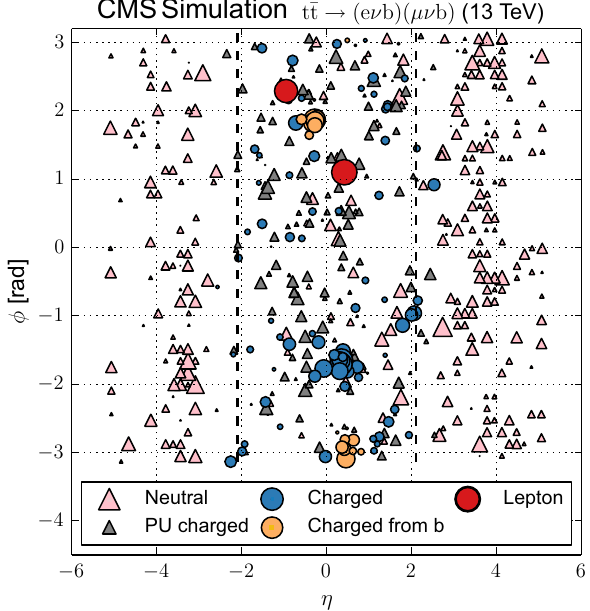
Fig. 1 Distribution of all PF candidates reconstructed in a Pw+Py8 simulated tt event in the η – φ plane. Only particles with p T > 900 MeV are shown, with a marker whose area is proportional to the particle p T . The fiducial region in η is represented by the dashed